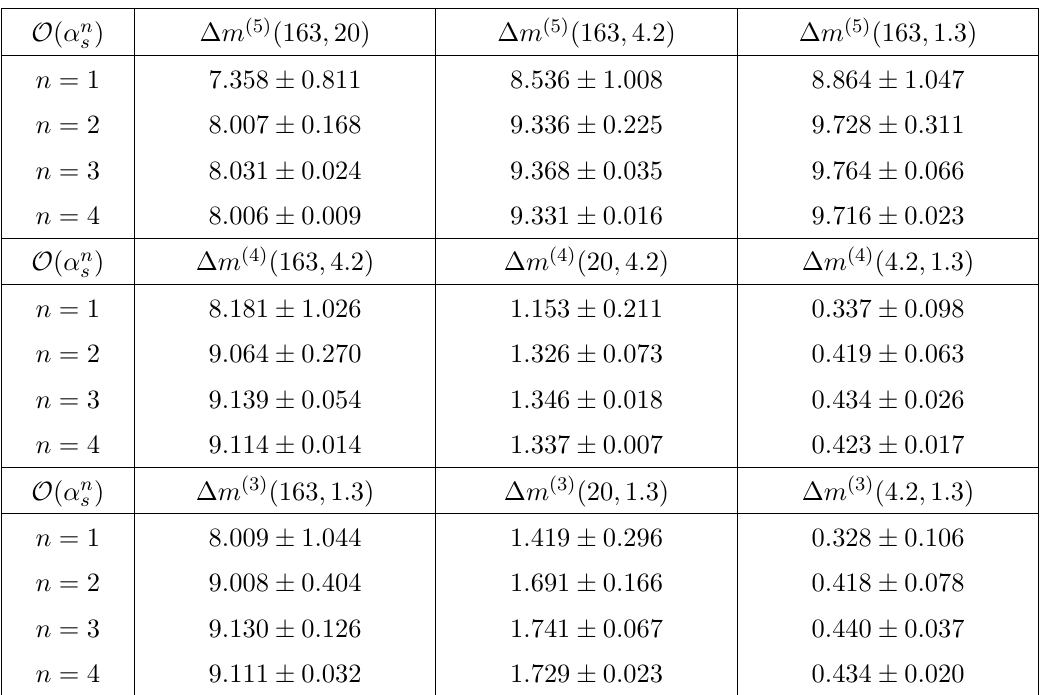
Table 1 . MSR mass di(cid:11)erences (cid:1) m ( n Q ) ( R; R 0 ) computed from R-evolution, for n Q = 3 ; 4 ; 5 active dynamical (cid:13)avors for scale di(cid:11)erences involving top, bottom and charm masses and the scale 20 GeV. The central values are obtained for (cid:21) = 1 and the uncertainties are symmetrized (cid:21) variations in the interval [0 : 5 ; 2]. For entries involving the scale m c the interval [0 : 6 ; 2 : 5] is used for (cid:21) variations. The numbers for (cid:1) m ( n Q ) ( R; R 0 ) are given in units of GeV. R-evolution equation at O ( (cid:11) n ) for n = 1 ; 2 ; 3 ; 4. The uncertainties are from (cid:21) variations s in the interval [0 : 5 ; 2] for the cases where scales above the charm mass scale 1 : 3 GeV